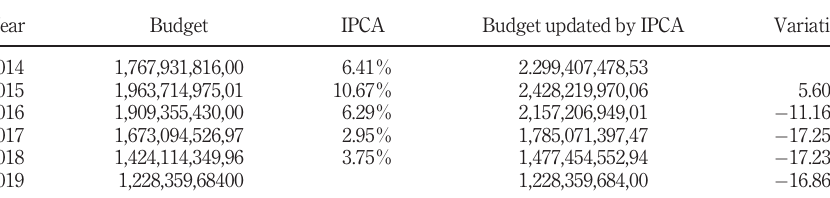
Table 2. Fapemig ’ s budget between 2014 and 2019 brought